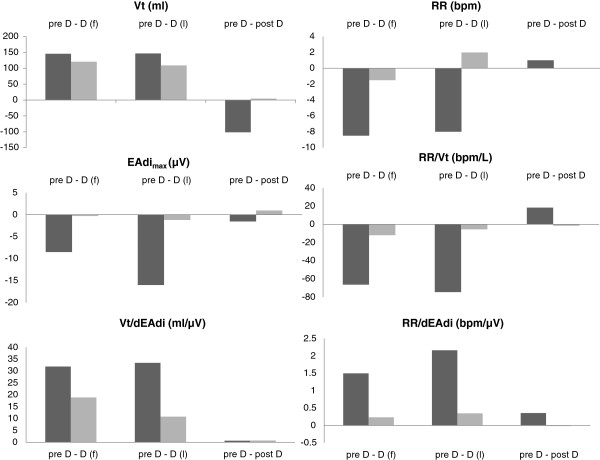
Changes of tidal volume, respiratory rate, electrical activity of the diaphragm, and weaning indices in relation to pre D in failure (n = 6) and success (n = 12) patients. The figure shows the median differences between D(f) and pre D, D(l) and pre D, and post D and pre D for tidal volume (VT), electrical activity of the diaphragm (EAdimax), respiratory rate (RR), and derived indices (RR/dEAdi, VT/dEAdi, and RR/VT) for failure and success patients. Dark columns show failure patients; light columns, success patients.